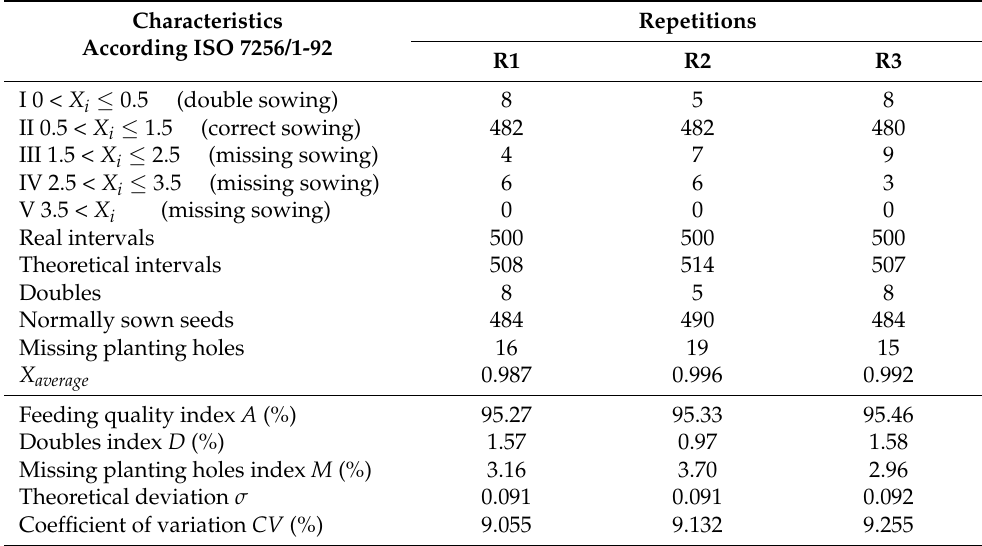
Table 5. Seed distribution and determination, in stationary conditions, of the quality indices of the studied row unit, for a density of 50,000 corn plants · ha − 1 and a working speed of 4 km · h − 1 . Characteristics